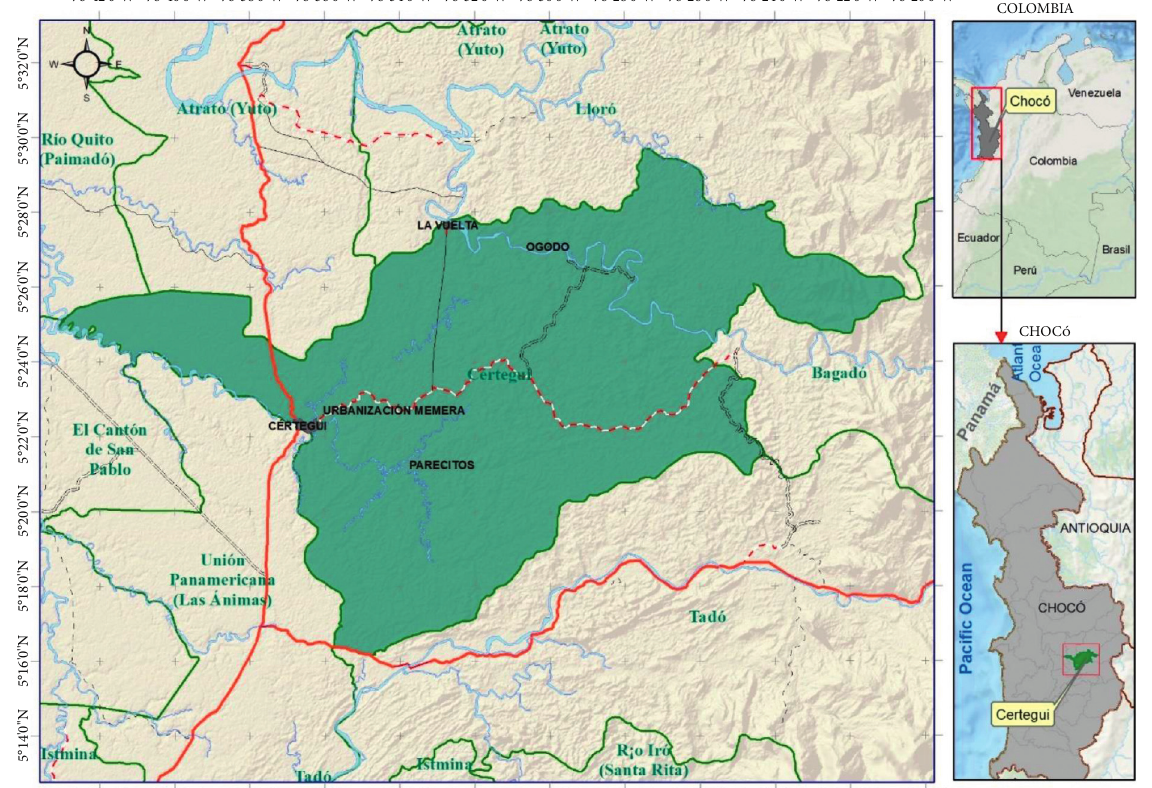
Figure 1: Location municipality of C´ertegui. Source: C´ertegui City Hall,